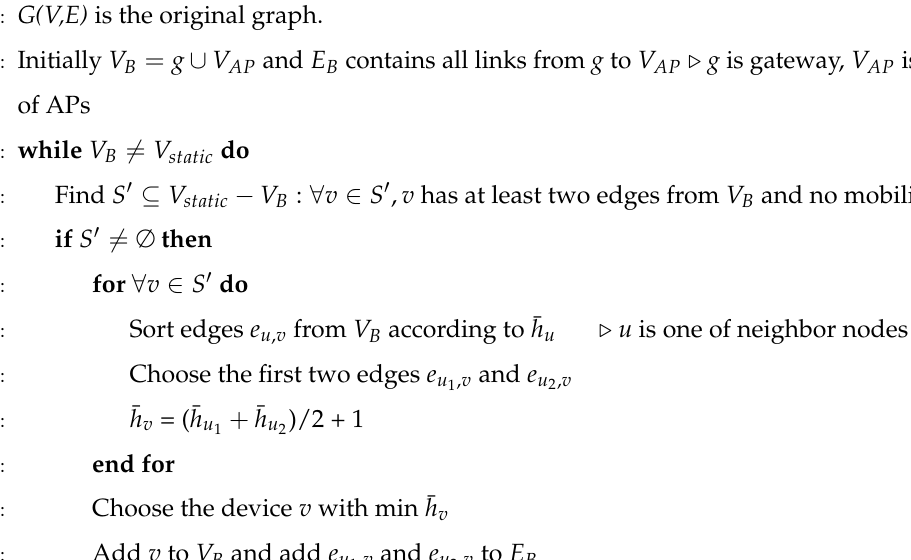
Algorithm 1 Pseudocode for Skeleton Broadcast Graph